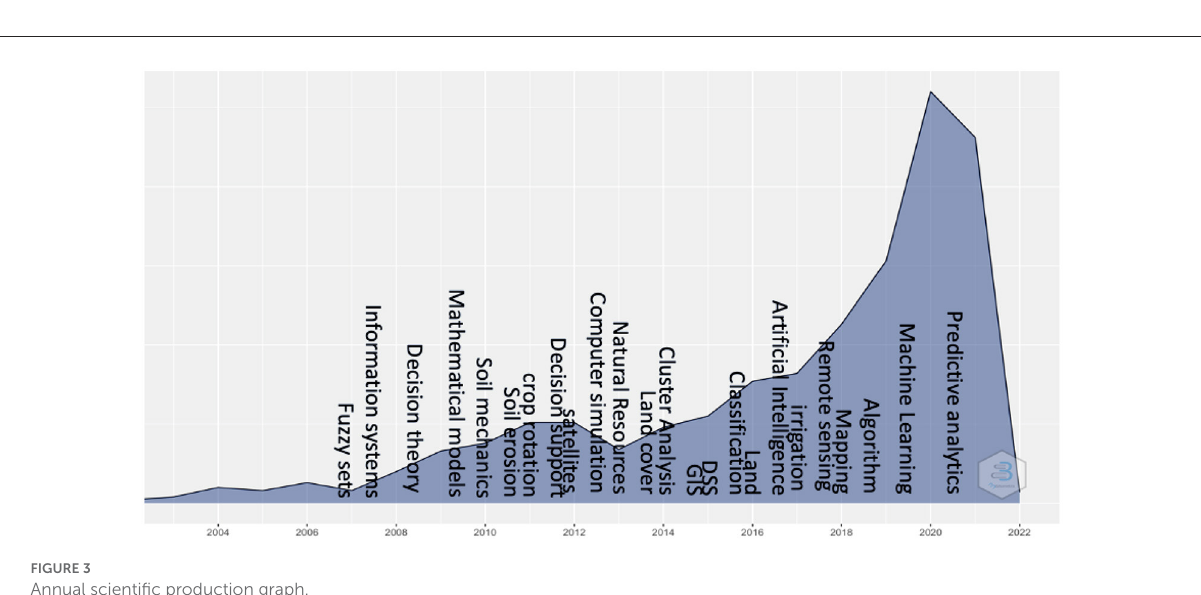
FIGURE3 Annual scientific production